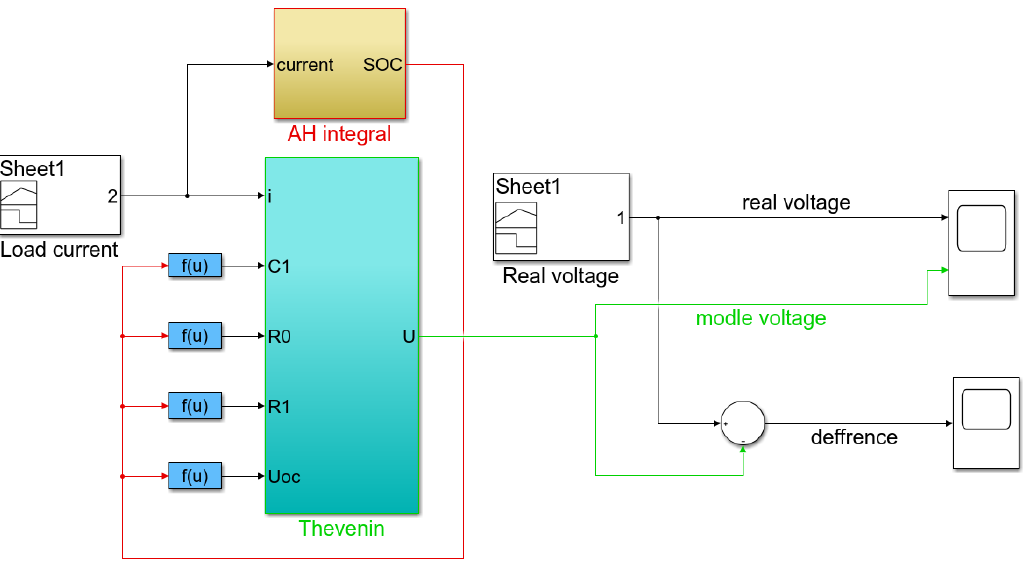
Figure 6. Simulink Model Verification Structural Diagram.